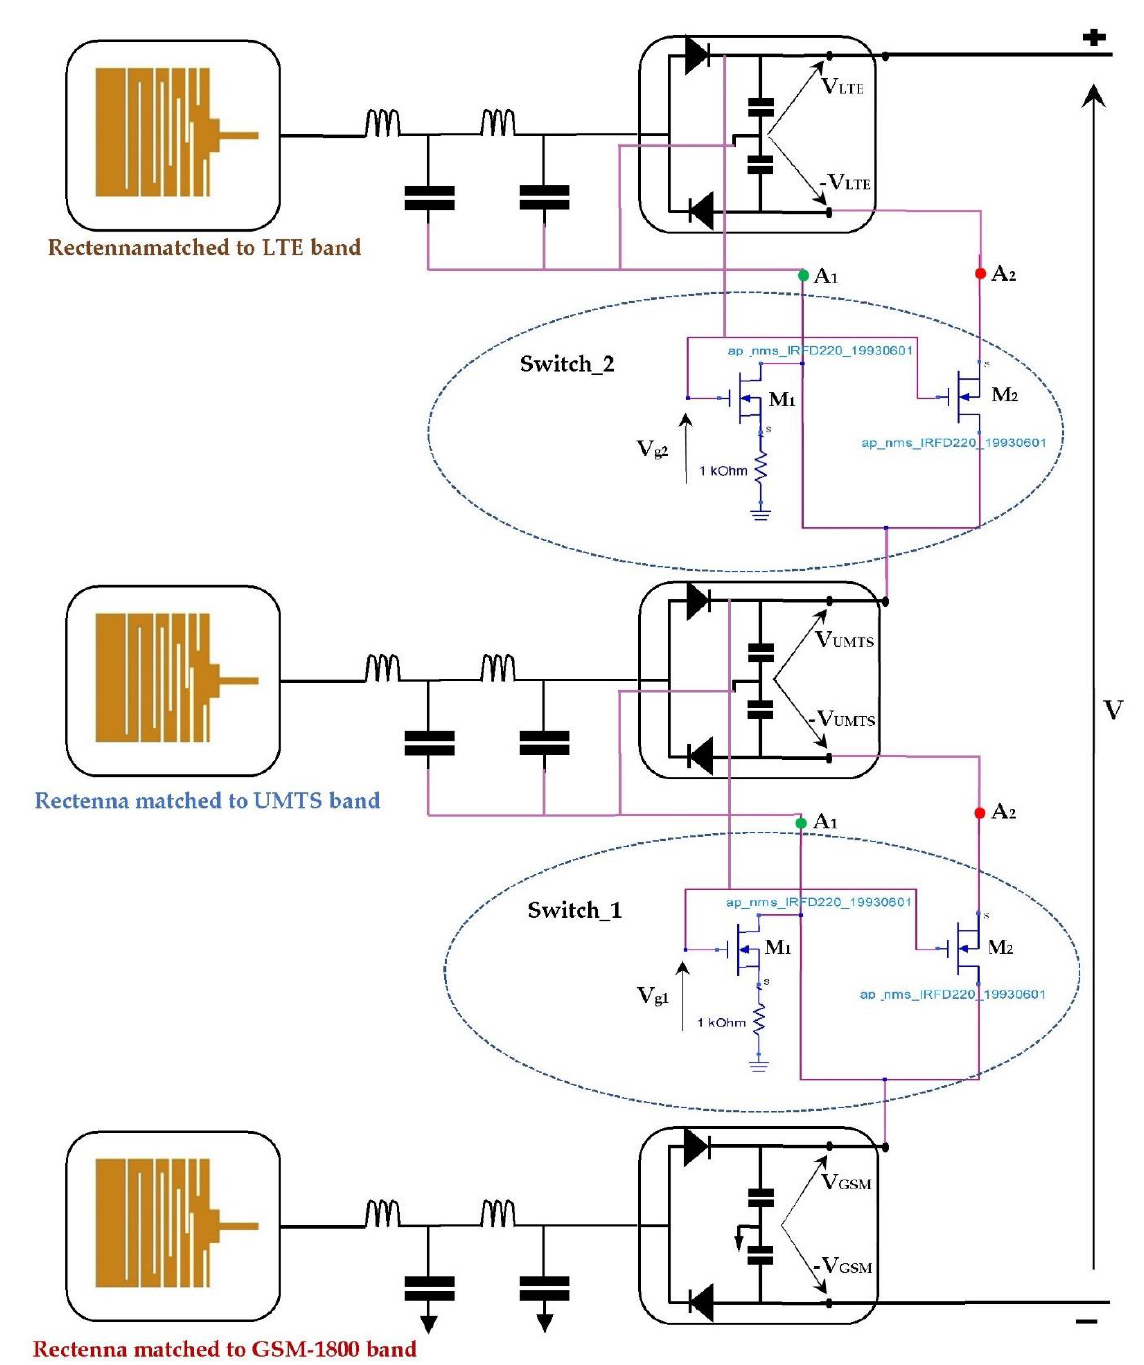
Figure 26. Proposed RF-EH system combining both previous architectures using the studied switch. A 1 and A 2 are the two positions corresponding to first and second architectures.